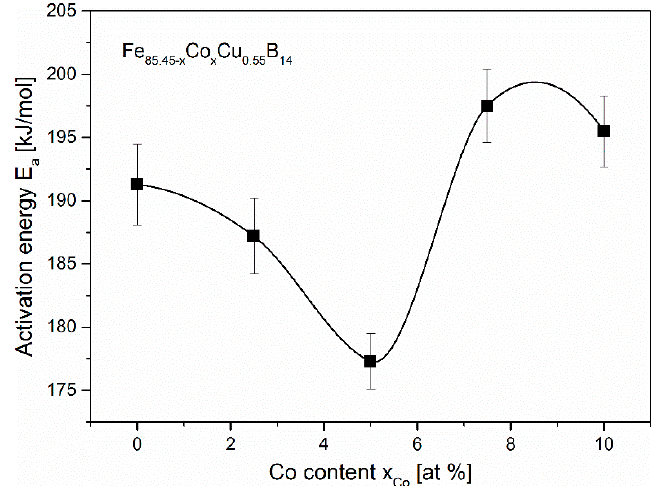
Figure 3. Activation energy Ea of α -Fe phase crystallization in the function of Co content. The plotted line is a guide for the eye.